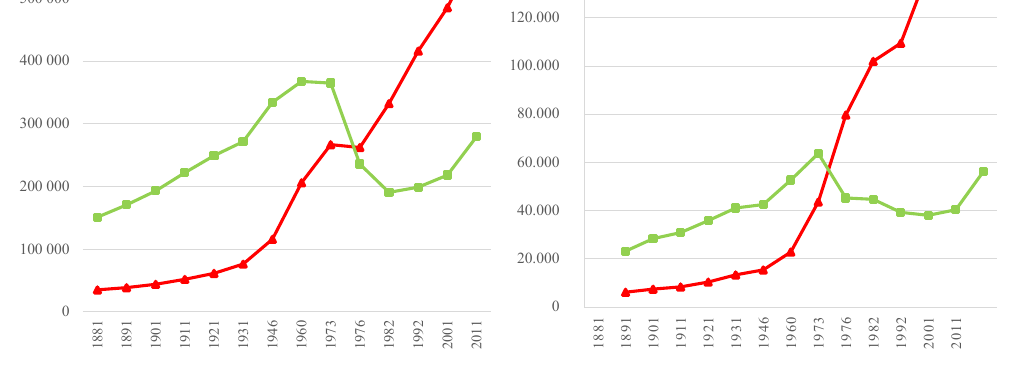
Figure 2. Urbanization trends in Cyprus and Limassol District.